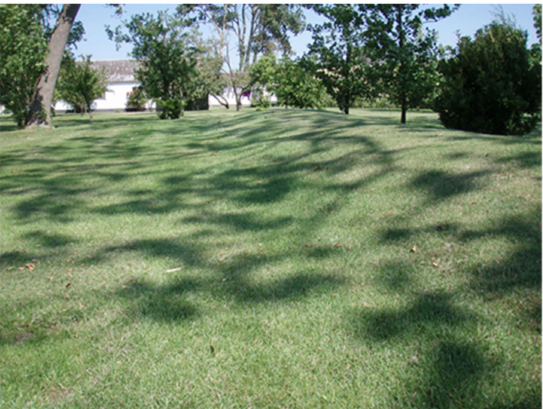
Figure 5. Remnants of a dike on the Danish island of Omø constructed after the 1872 storm, but later partly removed. Photo: Per